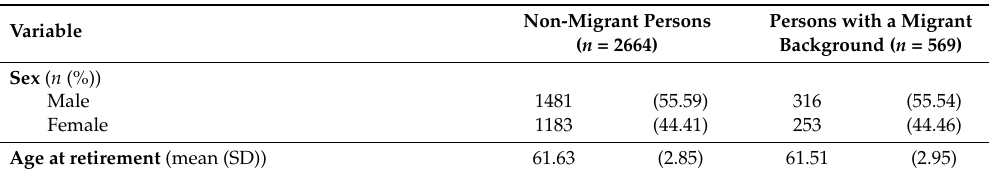
Table 1. Characteristics of study